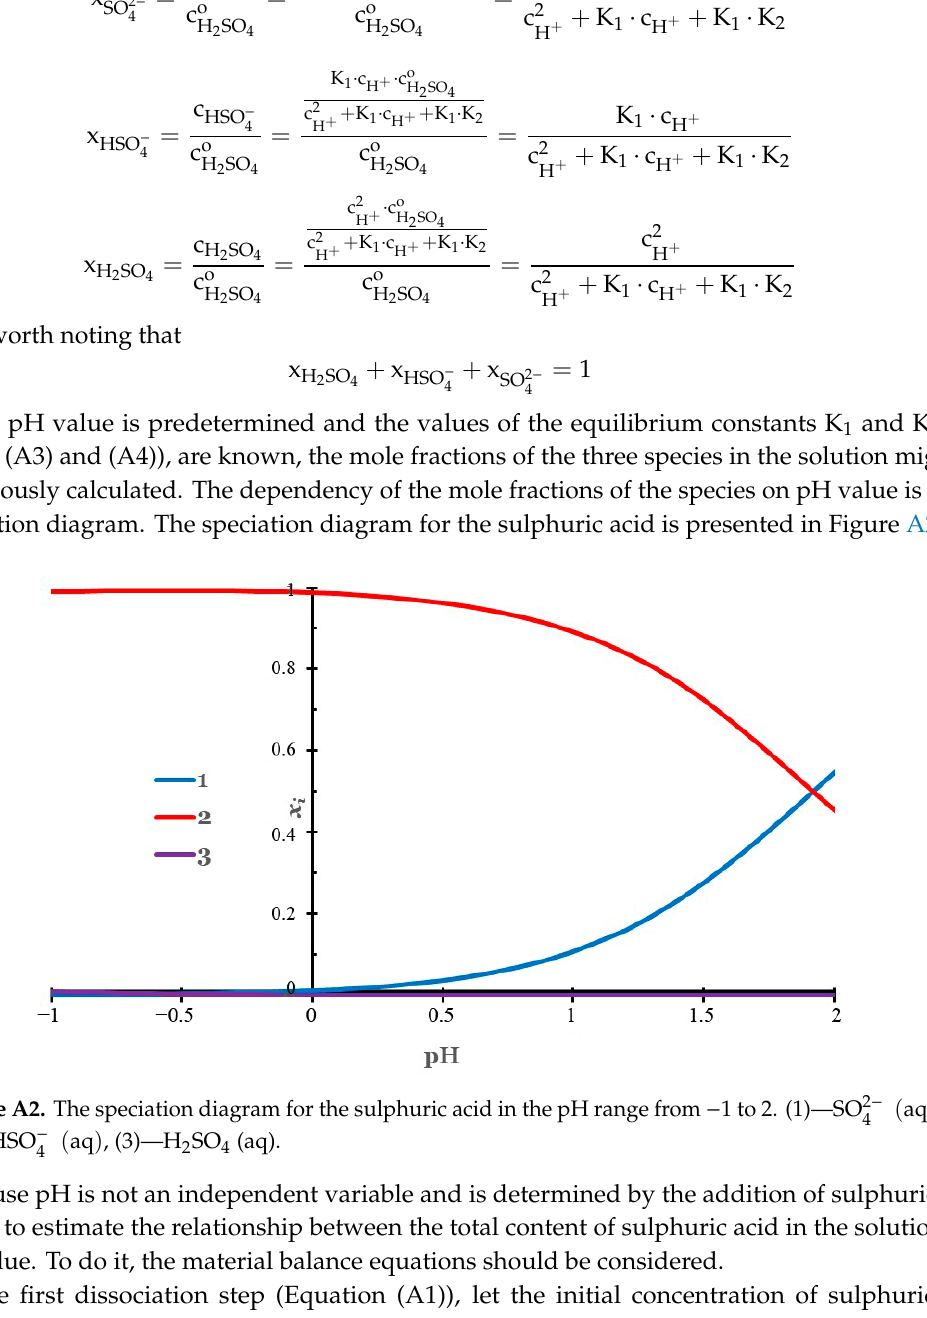
Table A2. Material balance of sulphuric acid dissociation. 2